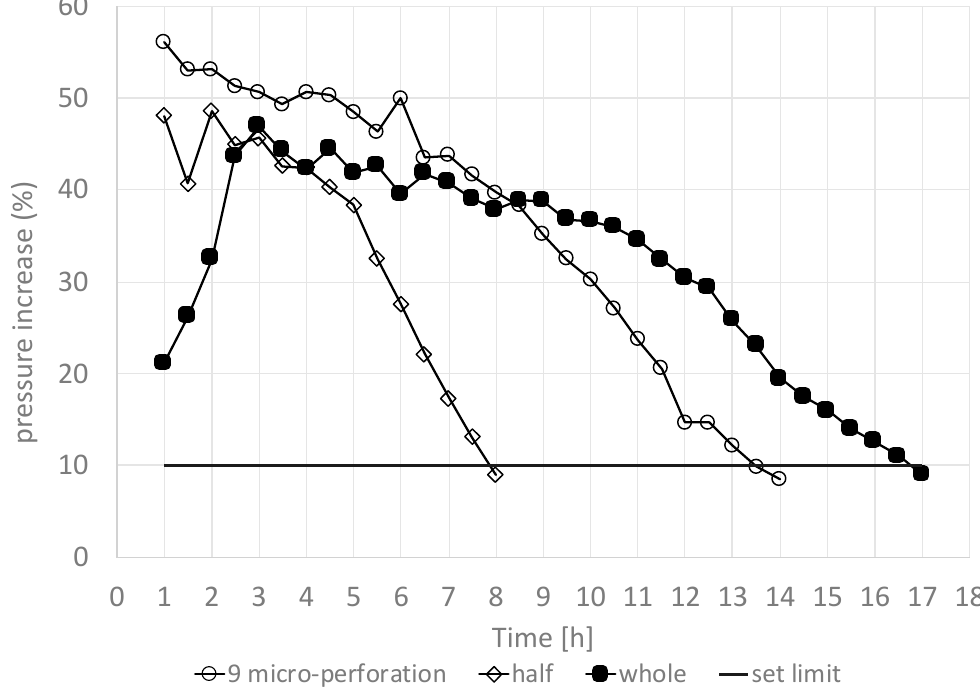
Figure 9. Appearance of blueberry fruit with nine (a) and three (b) CO 2 laser microperforations. The PIT and product temperature response were used to evaluate the effect of pretreatment on the primary drying time. Each test was conducted in triplicate to determine the average and standard deviation of the primary drying time. Figure 10 depicts the PIT for the blueberries that were whole and nontreated, cut in half, and microperforated nine times. It is interesting to note that for both cut- in-half and nine-times-perforated blueberries, the initial PIT value started higher than that of the whole nontreated fruit and decreased over time. This is due to the weakened pretreated skin or the area without skin being available to sublimation.